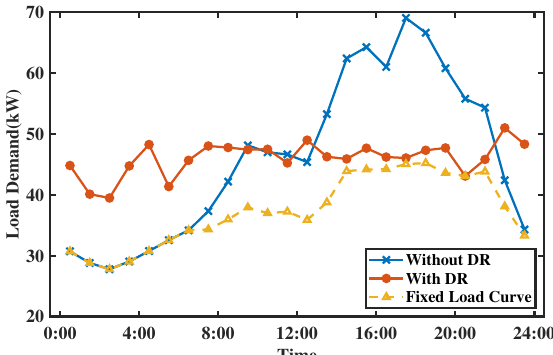
Figure 6. Fixed and total load curve with and without demand response